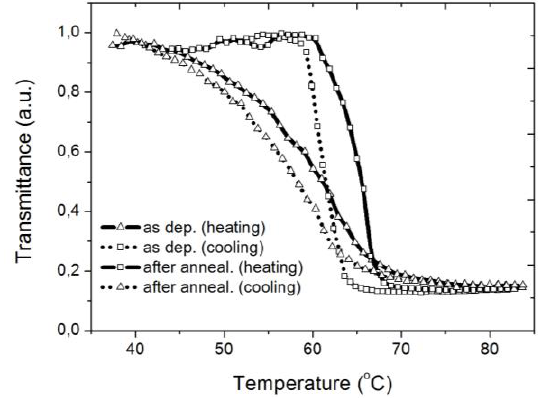
Fig. 2. The THz transmittance of VO 2 /r-Al 2 O 3 (as deposited and after annealing) films at different